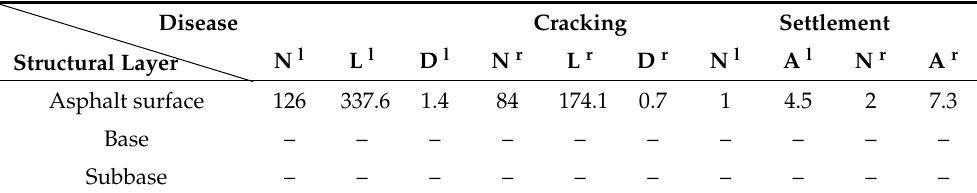
Table 1. The detection results of pavement defects investigation.